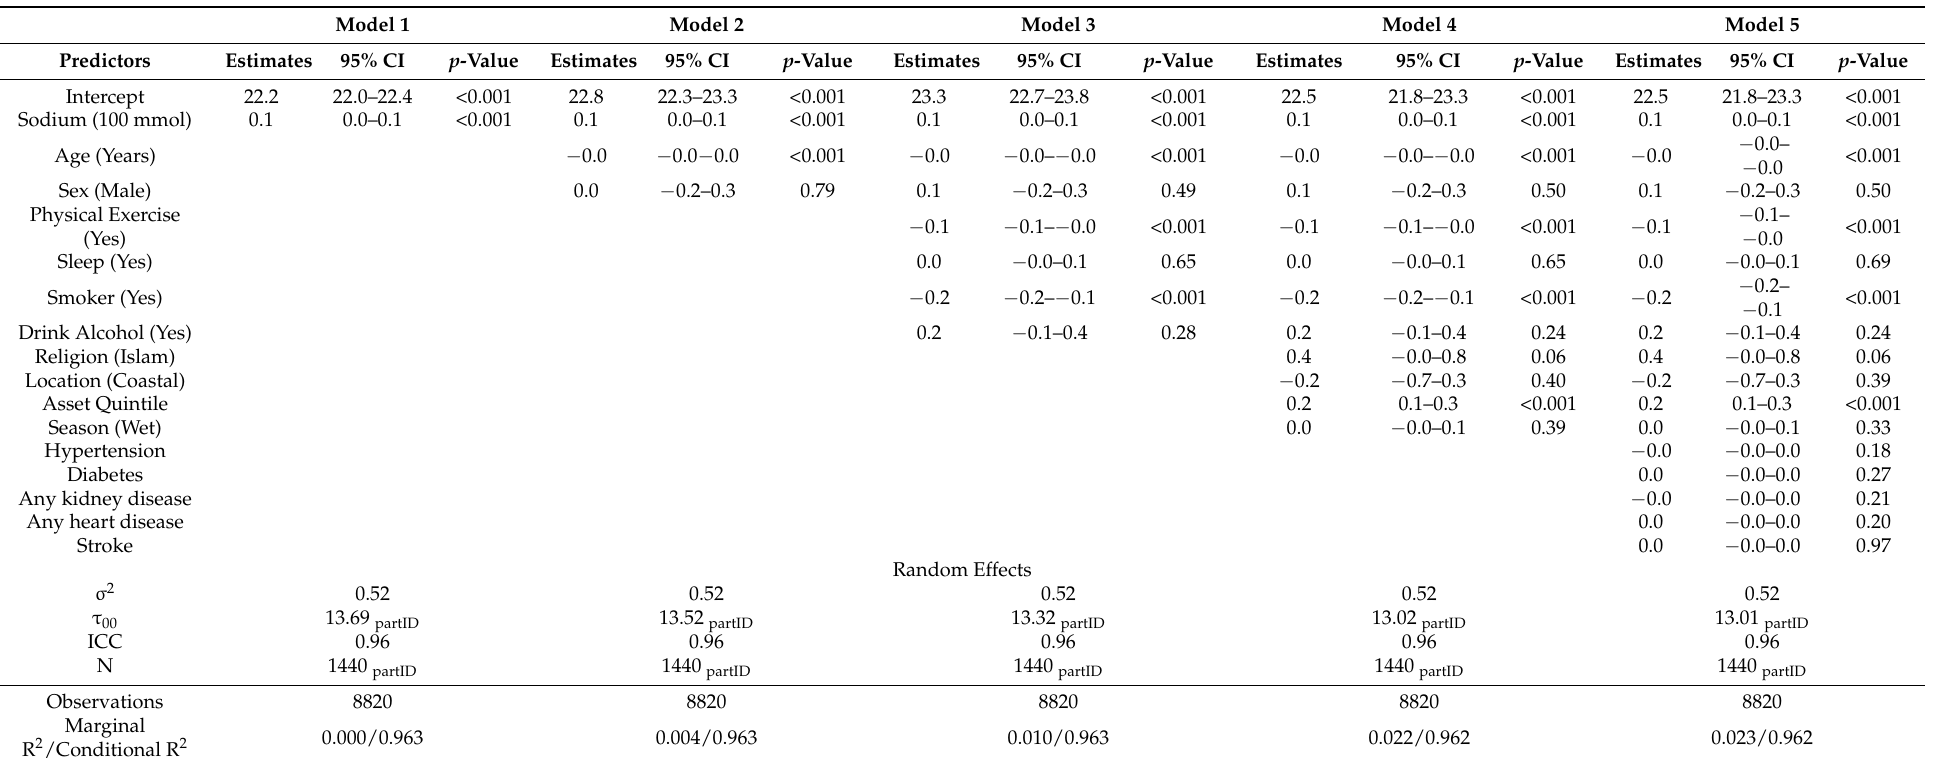
Table 3. Association between 24 h urinary sodium and mean BMI (kg/m 2